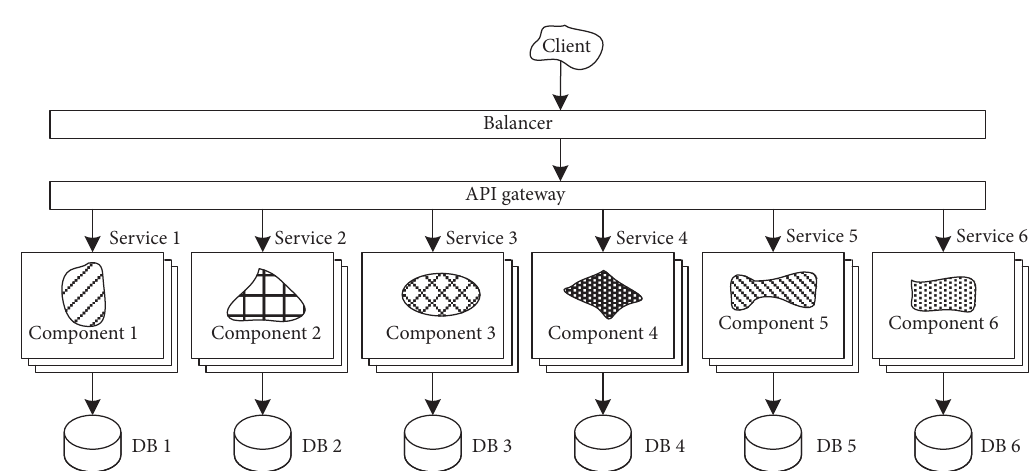
Figure 4: Framework of microservice